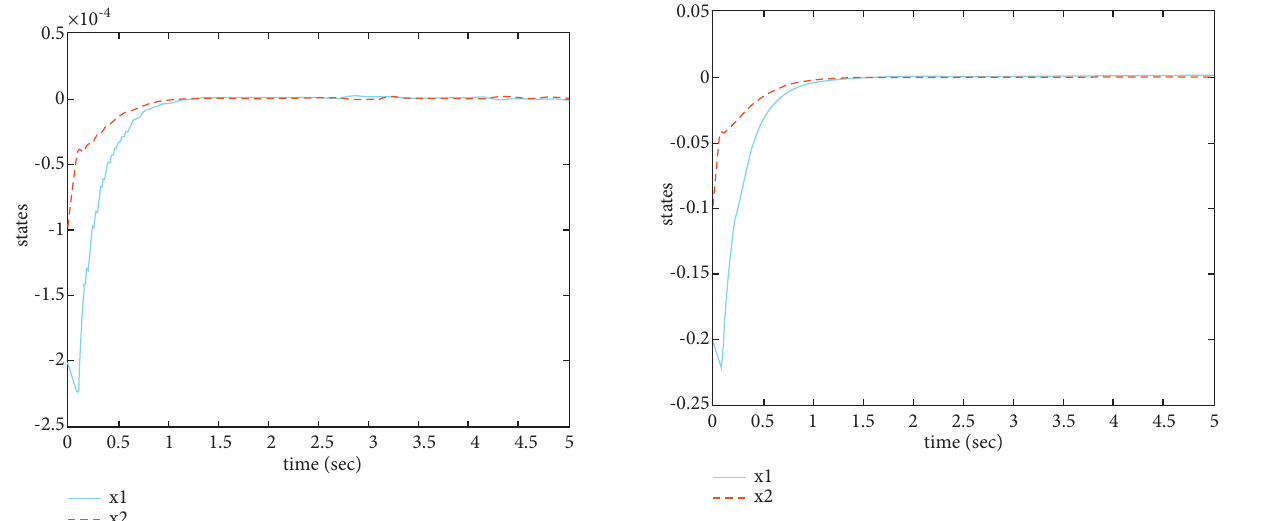
Figure 5: The switching signal of System (35) with a bounded input u ( t ) � cos ( 96 t